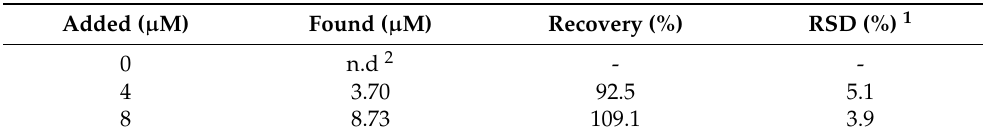
Table 2. Determination of DA in human urine